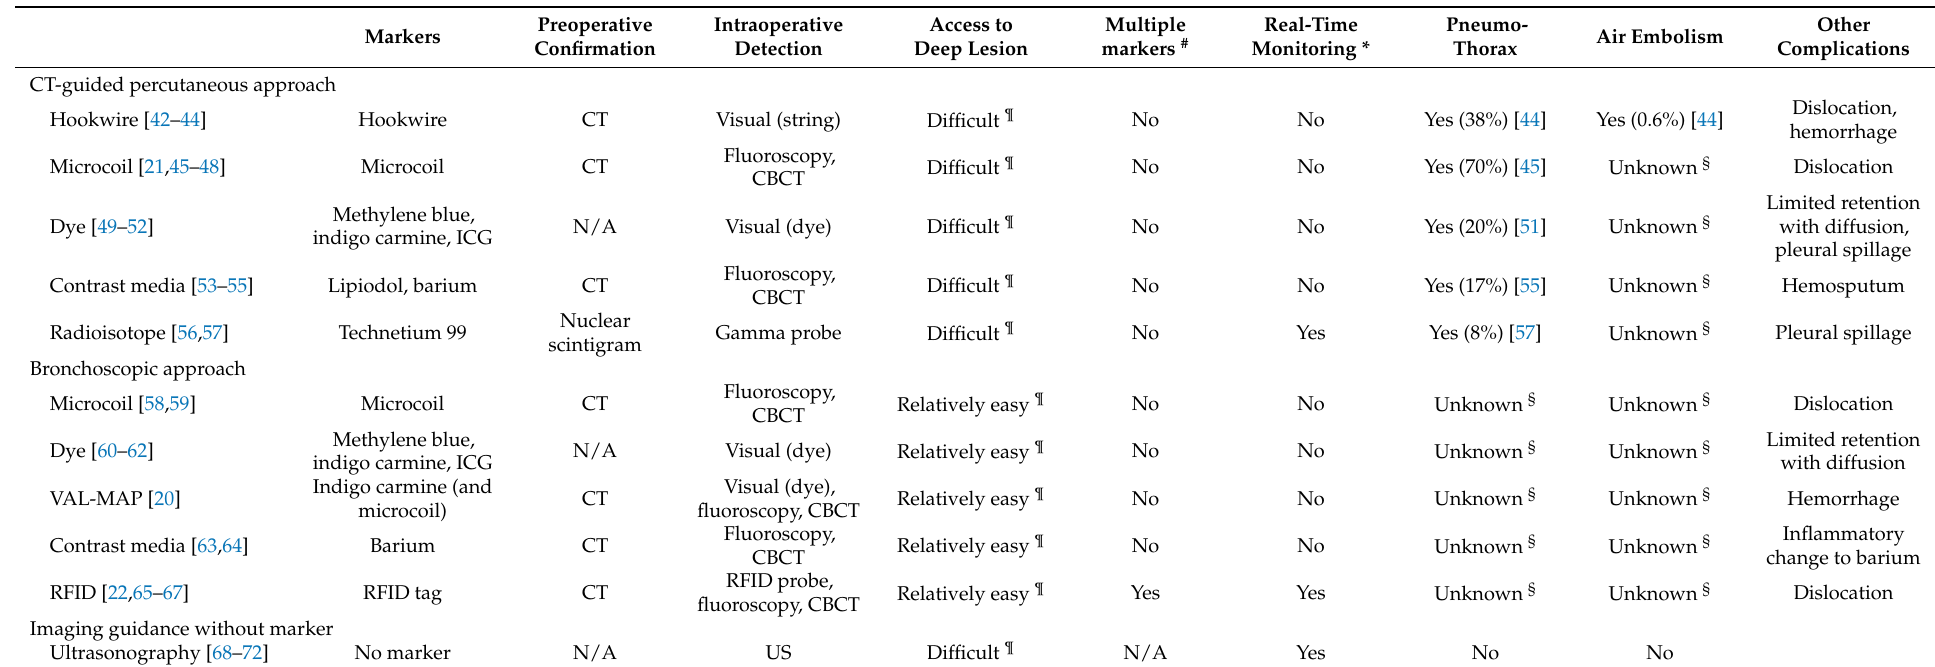
Table 1. Characteristics of the localization